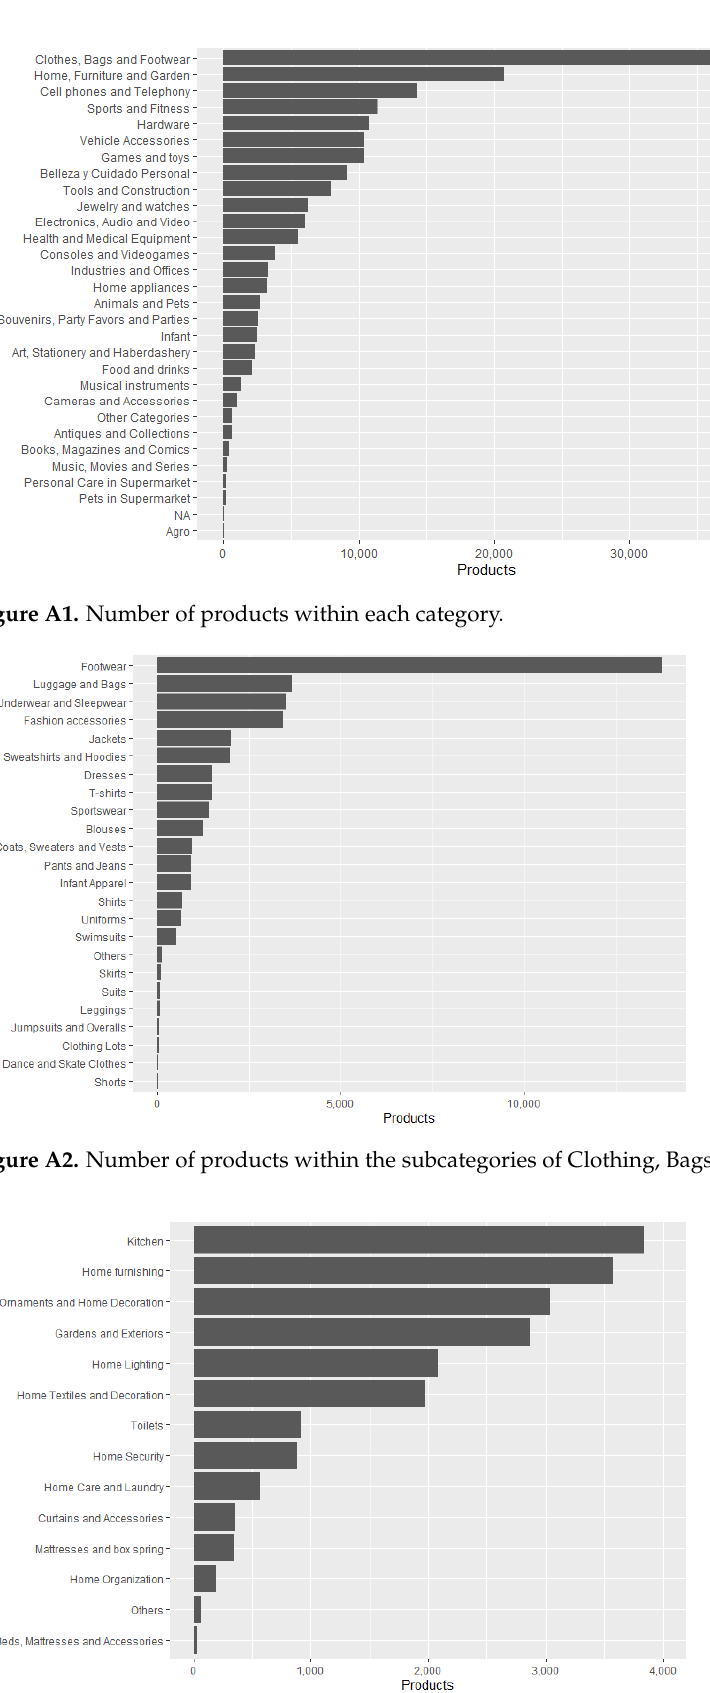
Figure A3. Number of products within the subcategories of Home, Furniture, and